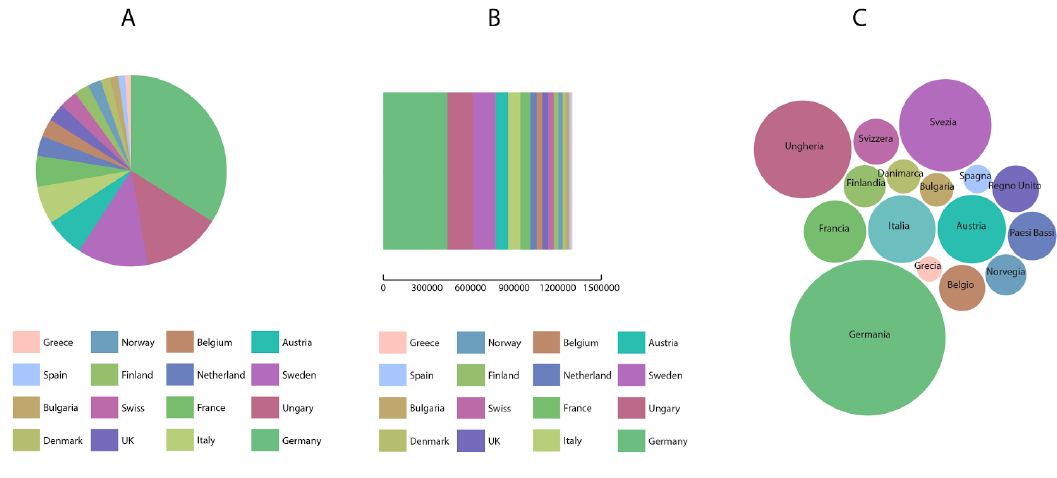
Figure 4. Three hypothetical forms of data visualization for first-time asylum applications in Europe (2015—source: